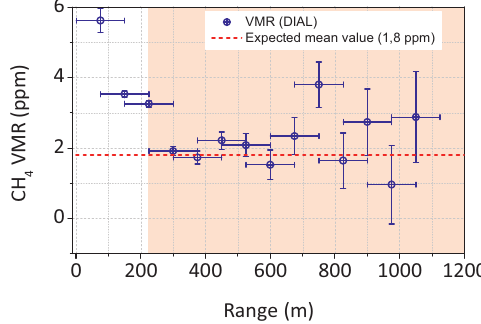
Fig. 2. NAOMI GAZL measurement for atmospheric CH 4 : volume mixing ratio (VMR) as a function of the range, for an integration time of 250 s and a measurement resolution of 150 m. The red dotted line corresponds to the expected 1.8 ppm atmospheric concentration, and the white area corresponds to the lidar blind zone.